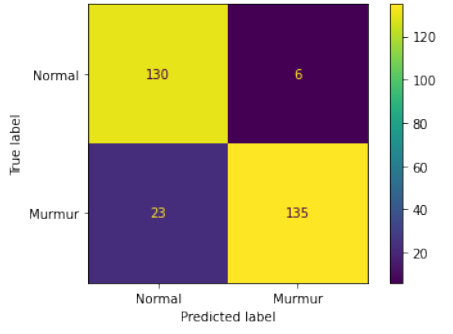
Figure 9. Confusion